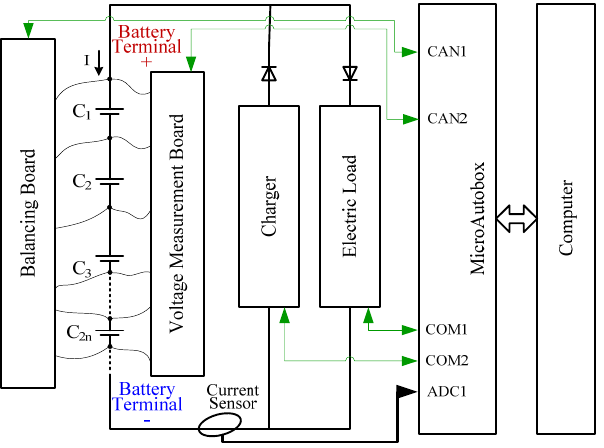
Figure 9. The structure of the experimental battery test workbench.